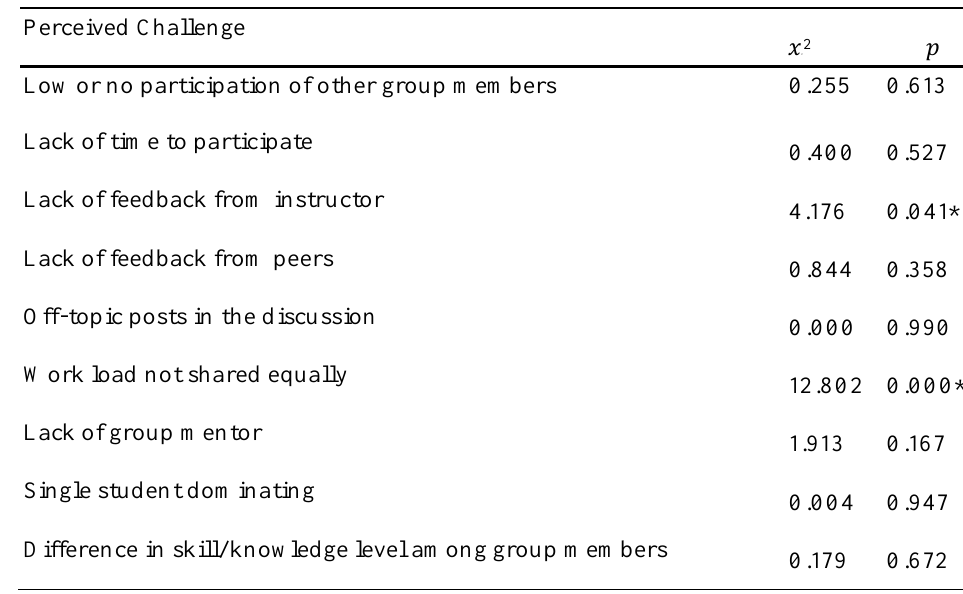
Associations Between University Type (Private or Public) and the Perceived Challenges in Using Online Collaborative Learning Environment Perceived